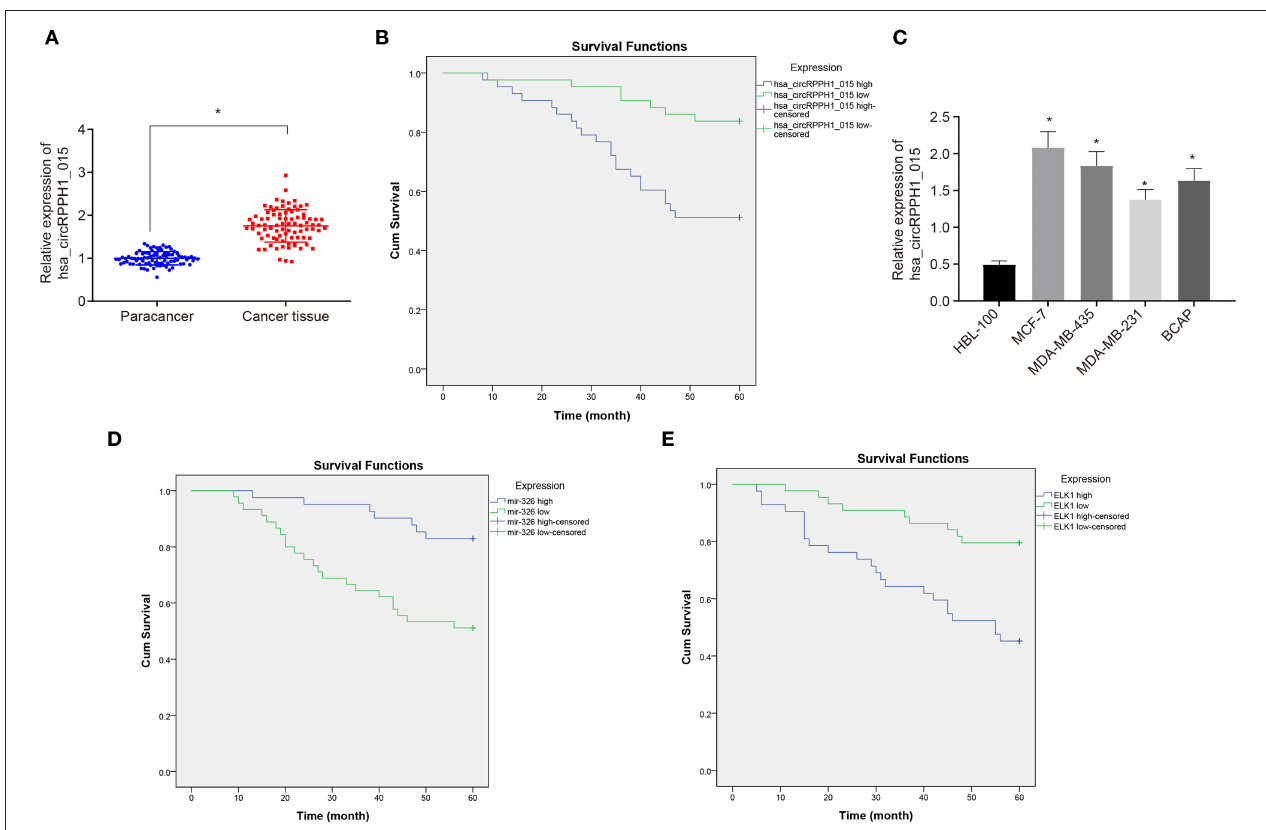
FIGURE 2 | The expression of hsa_circRPPH1_015 was associated with the progression of BC. (A) Hsa_circRPPH1_015 expression in BC tissues and adjacent normal tissues determined by RT-qPCR. (B) The correlation analysis between hsa_circRPPH1_015 expression and prognosis of patients with BC by Kaplan–Meier survival analysis. (C) The expression of hsa_circRPPH1_015 in normal breast cell lines and BC cell lines determined by TaqMan-PCR assay. (D) Corelation analysis of prognosis and survival in patients with high and low expression of miR-326 by Kaplan–Meier survival analysis. (E) Corelation analysis of prognosis and survival in patients with high and low expression of ELK1 by Kaplan–Meier survival analysis. * p < 0.05 vs. the adjacent normal tissues or HBL-100 cell line. The quantitative analysis results were measurement data and compared by paired t -test between two groups and by one-way ANOVA among multiple groups. Values were obtained from three independent experiments. BC, breast cancer; ELK1, ETS-domain containing protein; RT-qPCR, reverse transcription quantitative polymerase chain reaction; ANOVA, analysis of